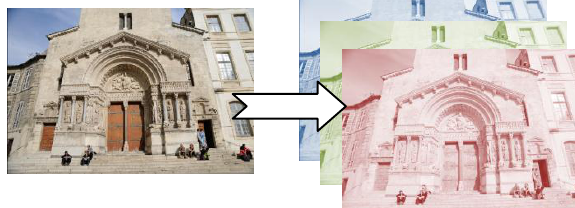
Figure 4: Structure of a TIFF file with the three color’s layers: Red, Green, Blue